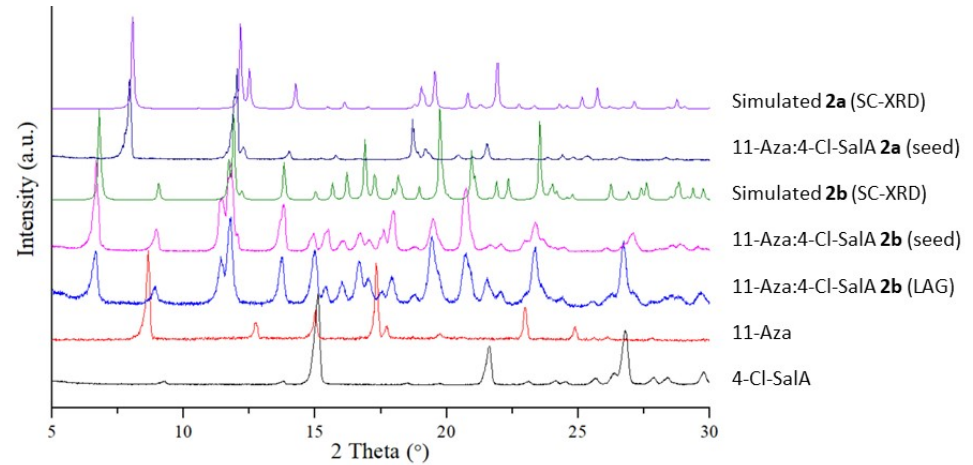
Figure 2. Powder X-ray diffractograms for 2a (from solution growth after hetero-seeding with 1 ) and 2b from LAG along with the coformers 11-Aza and 4-Cl-SalA.